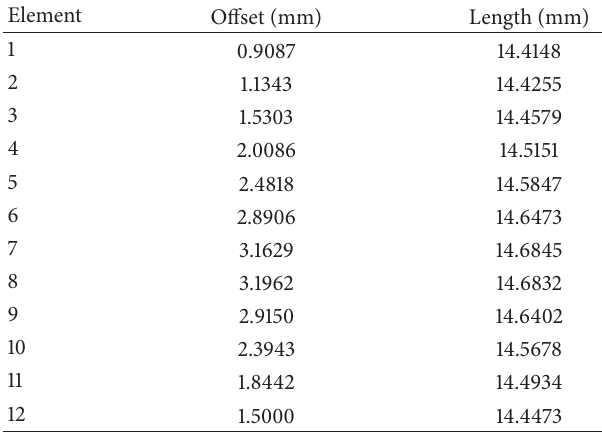
Table 2: Parameters of the traveling wave